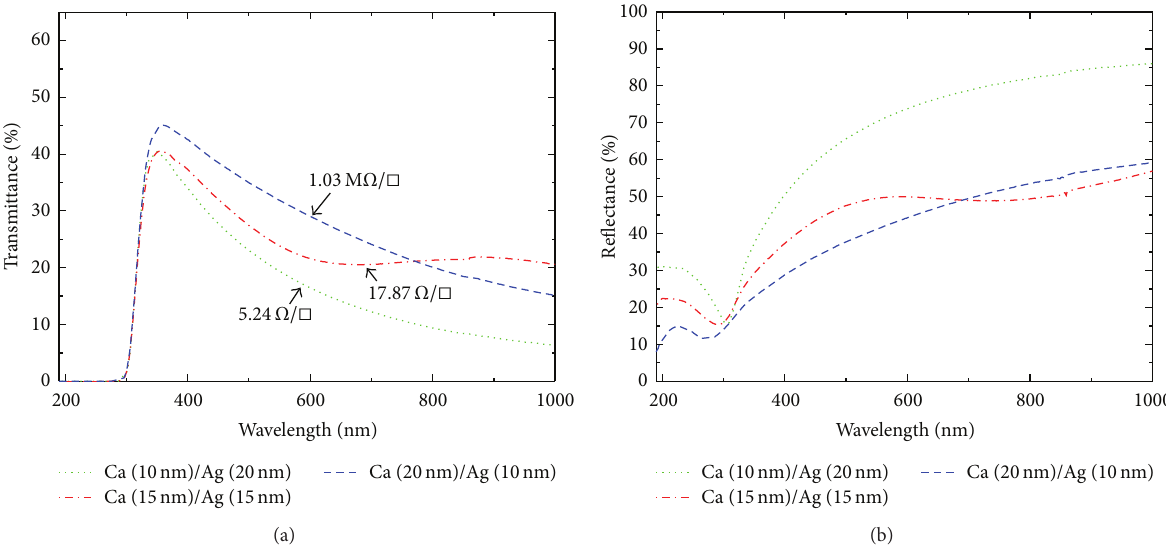
Figure 4: (a) The wavelength-dependent transmittance spectra with corresponding sheet resistances and (b) the wavelength-dependent reflectance spectra of Ca (10nm)/Ag (20nm), Ca (15nm)/Ag (15nm), and Ca (20 nm)/Ag (10nm) electrodes deposited on glass